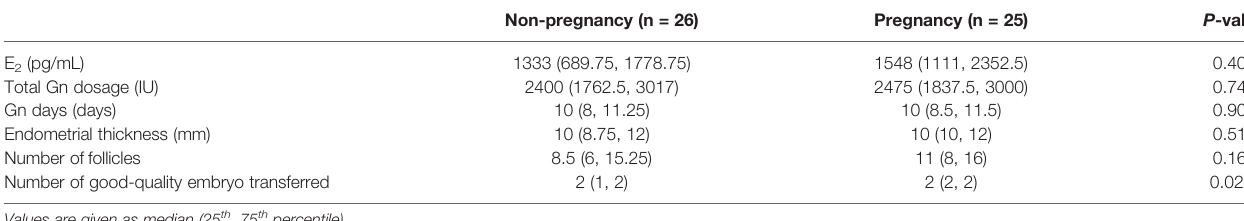
TABLE 2 | Supplement of baseline data for fresh IVF-ET cycle patients.